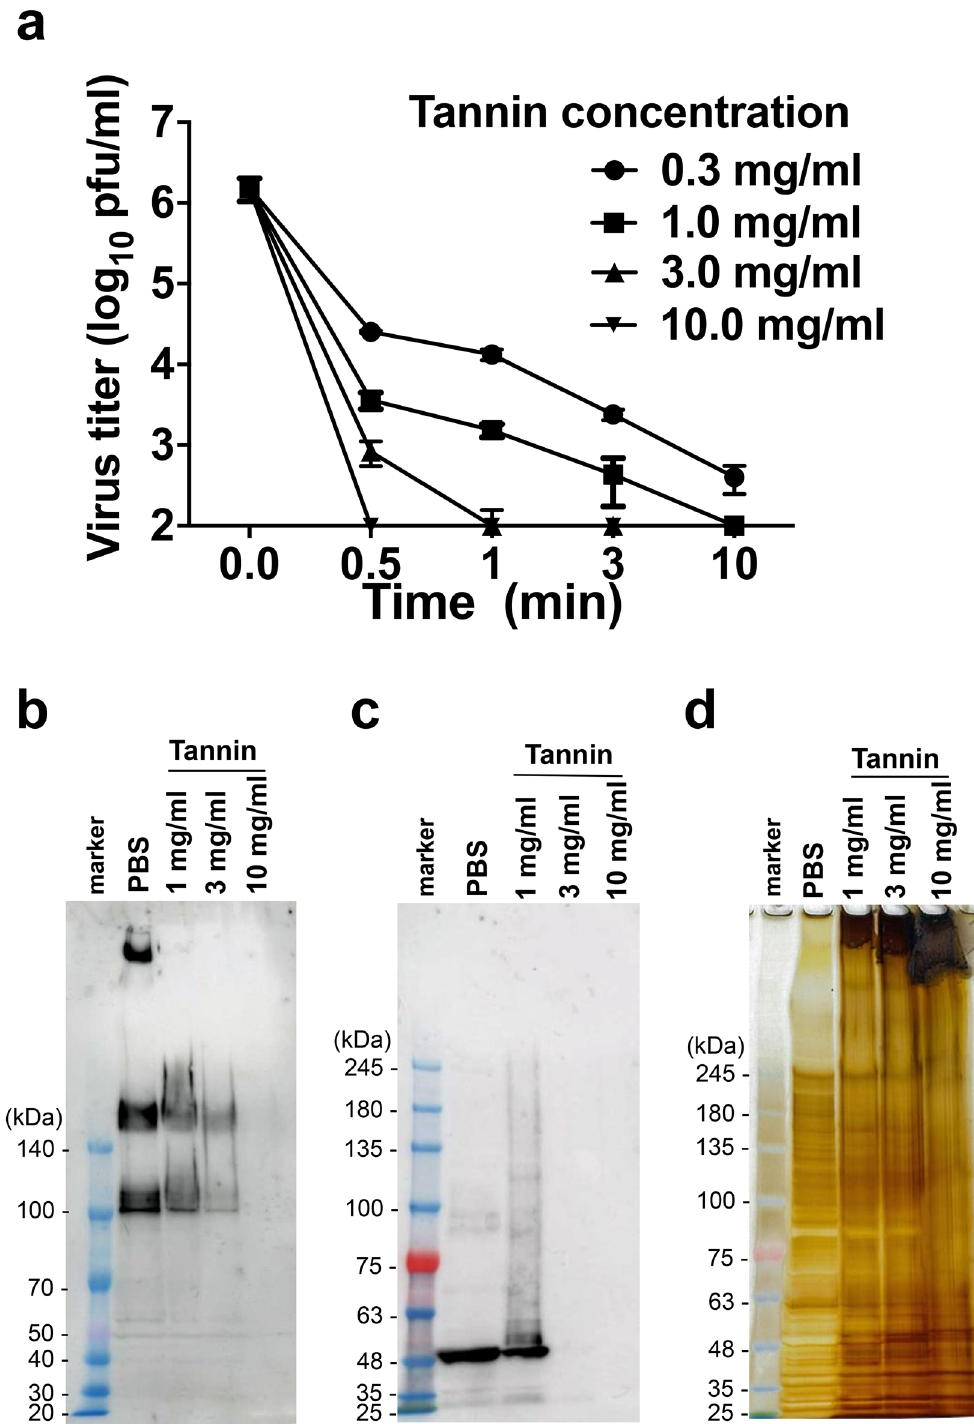
Figure 1. In vitro examination of persimmon-derived tannin against SARS-CoV-2. ( a ) Tannin powder was dissolved in distilled water and mixed with an amount of SARS-CoV-2 solution equal to 1.0 × 10 7 plaque- forming units (pfu)/ml. After 30 s, 1 min, 3 min, and 10 min of reaction time, bovine serum albumin adjusted to 1% using PBS was added to block the tannin effect. The SARS-CoV-2 titers of each tannin-virus solution were measured using the plaque assay method. Data are shown as the mean ± SEM of three independent experiments. ( b–d ) SARS-CoV-2 (1.0 × 10 6 pfu) was incubated with tannin (1, 3, and 10 mg/ml) or PBS for 3 min, then ( b ) SARS-CoV-2 spike and ( c ) nucleocapsid proteins were analyzed by western blotting and ( d ) sodium dodecyl sulfate polyacrylamide gel electrophoresis (SDS-PAGE) with silver staining. A major band at the top of the lane, and the major bands of approximately 180 kDa and 90 kDa are the trimeric, full-length, and cleaved spike proteins of SARS-CoV-2, respectively ( b ). A major band of approximately 55 kDa is the SARS-CoV-2 nucleocapsid protein ( c ). A major band at the top of the lane is an aggregate of tannin and viral proteins ( d